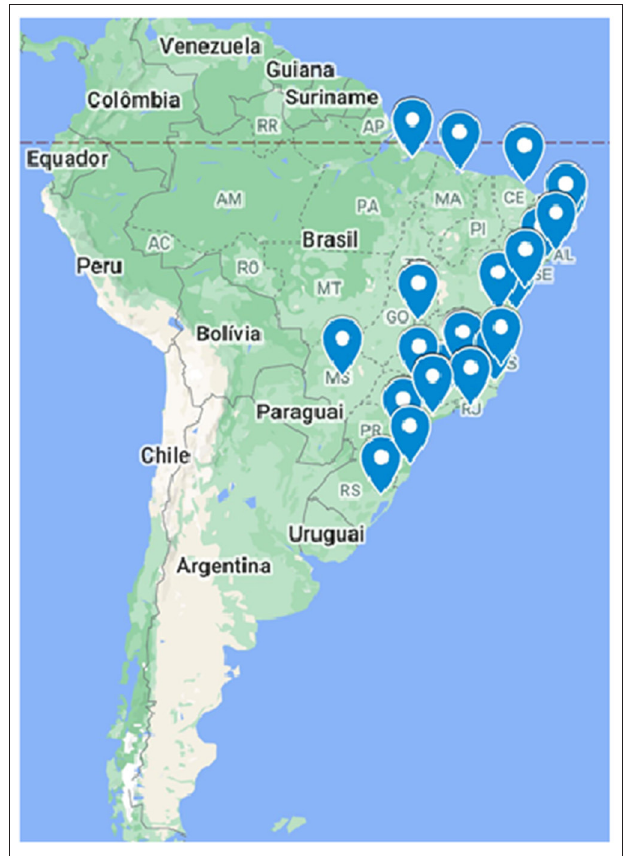
FIGURE 3 | Distribution of centers that offer care for people living with HTLV-1/2 in